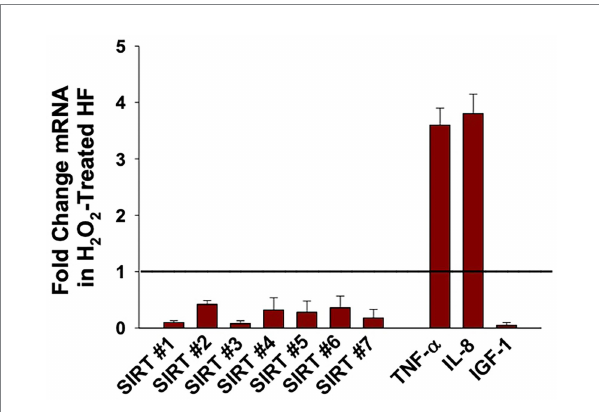
FIGURE 2 Effect of Hydrogen Peroxide (H 2 O 2 ) on the expression of Sirtuins (1 to 7), TNF α , IL-8, and IGF-1 in oxidant-induced senescent Dermal Human Fibroblasts (DHF). Neonatal-derived HF were treated with 600 μ M of H 2 O 2 for 2 h, for oxidant-induced cell senescence and then harvested 72 h later. The data are mean ± SE levels of mRNA from different sirtuins (1–7) normalized to 18 s and cytokines relevant to fibroblast senescence from 3 to 4 different experiments using triplicate samples. The statistical analysis was done using Student t test where all values listed are statistically ( p < 0.05) different from control values set at 1 (see line). Please see reference (87) for further details as to the characterization of the DHF treated with vehicle vs. pro-oxidative